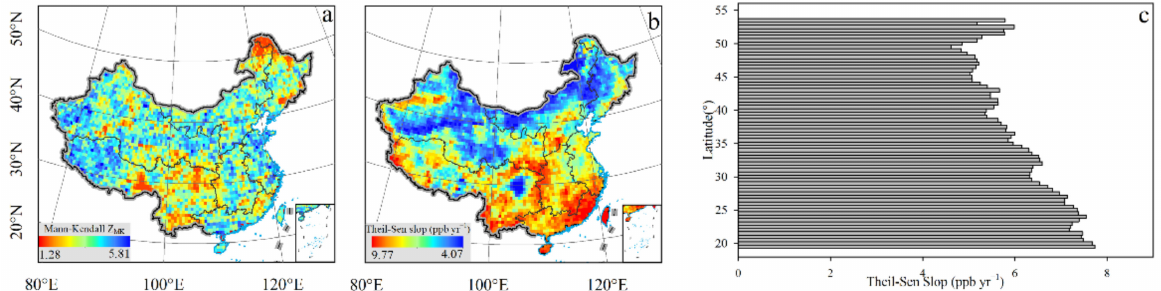
Figure 5. Spatial distribution of the annual rate of increase in XCH 4 concentrations from 2003 to 2021. ( a ) Mann–Kendall trend test map for XCH 4 concentrations over China; ( b ) Theil–Sen slope trend map for XCH 4 concentrations over China; ( c ) Theil–Sen slope distribution at different latitudes, varying by 0.5 ◦